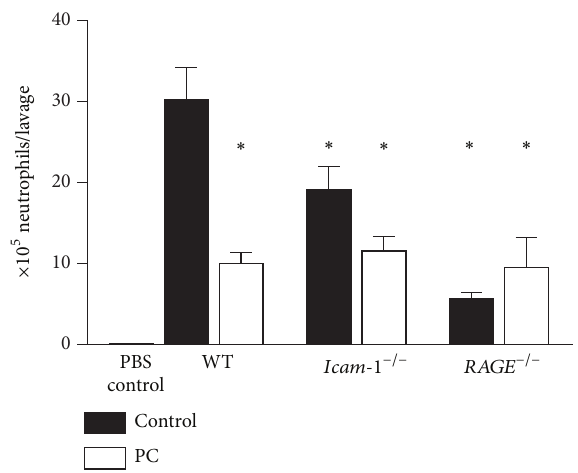
Figure 4: Effect of PC treatment on bronchoalveolar neutrophil emigration during LPS-induced ALI in wild-type, RAGE −/− , and Icam-1 −/− mice. In a 6-hour model of LPS-induced ALI, the number ofintra-alveolarneutrophilsobtainedbybronchoalveolarlavagewas analyzed in wild-type, Icam-1 −/− , and RAGE −/− mice treated with 100U/kg PC 30min after intratracheal LPS instillation ( Escherichia coli 0111:B4 (10 𝜇 g LPS/50 𝜇 L PBS)). All values are presented as mean ± SEM from at least three mice per group. Significant differences ( 𝑃 < 0.05 ) to WT control mice are indicated by the